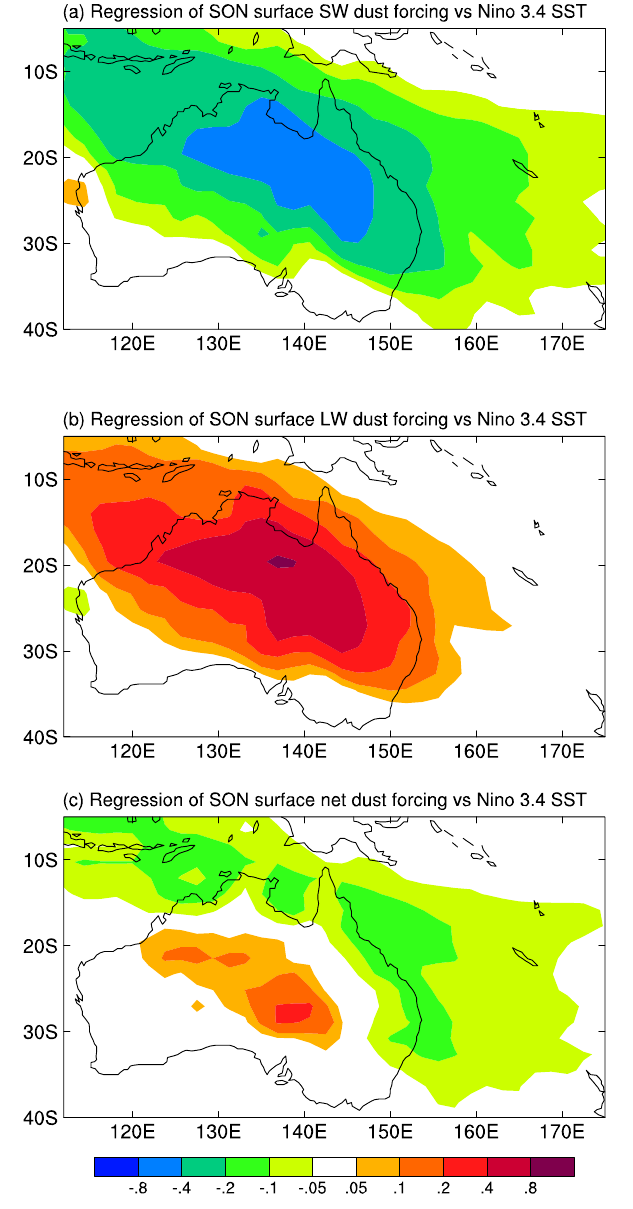
Fig. 10. Regression slopes of dust surface radiative forcing ver- sus Ni˜no3.4 SST from the DUST run for SON (in Wm − 2 K − 1 ): (a) shortwave, (b) longwave, (c) net.